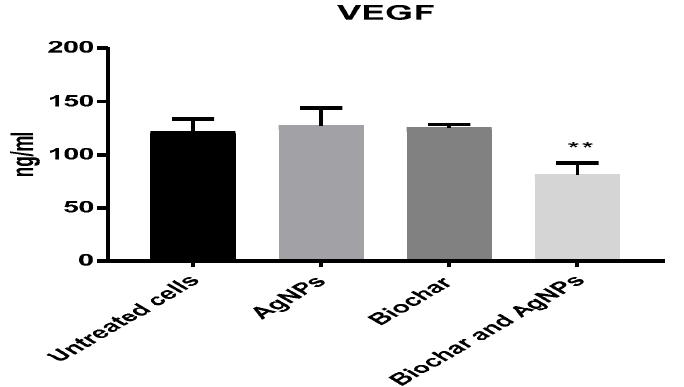
Figure 8. The effect of AgNPs at 6 µg/mL and biochar at 200 µg/mL on the expression of VEGF in 72 h cultures. The results are expressed as means of three measurements ± SD ( n = 3–4 independent replicates). **: p < 0.01 compared to respective untreated cells.